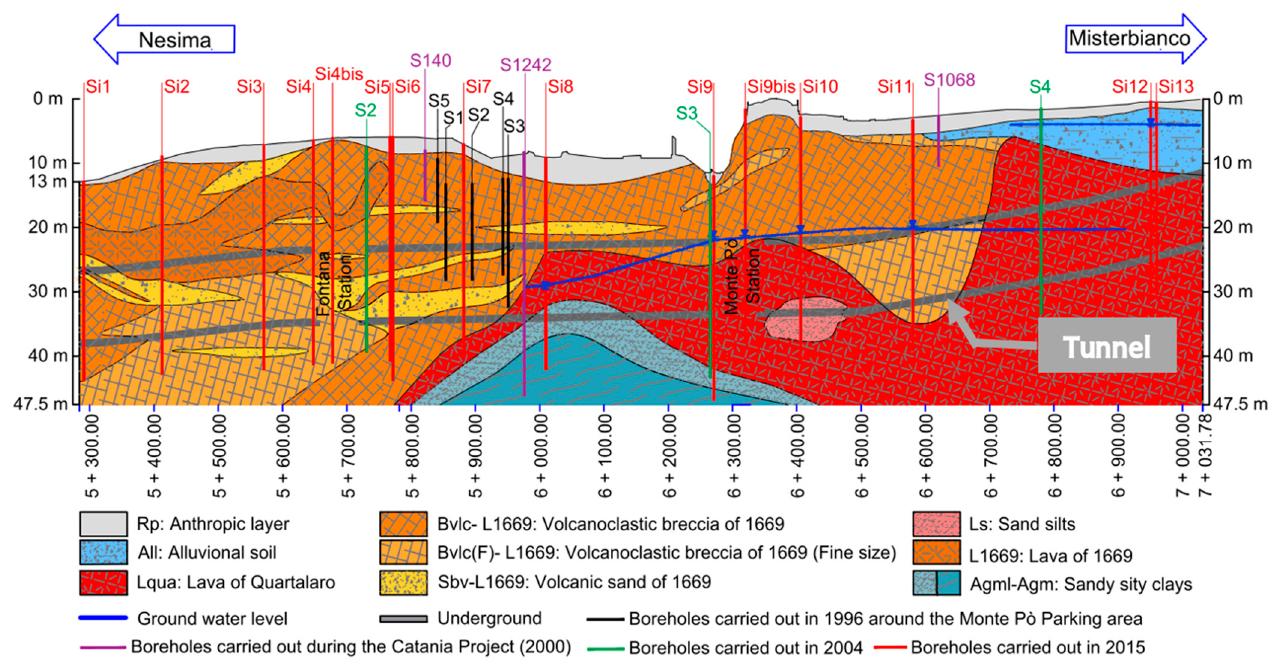
Figure 4. Soil profile and positions of the boreholes along the Nesima-Misterbianco segment from the design phase.